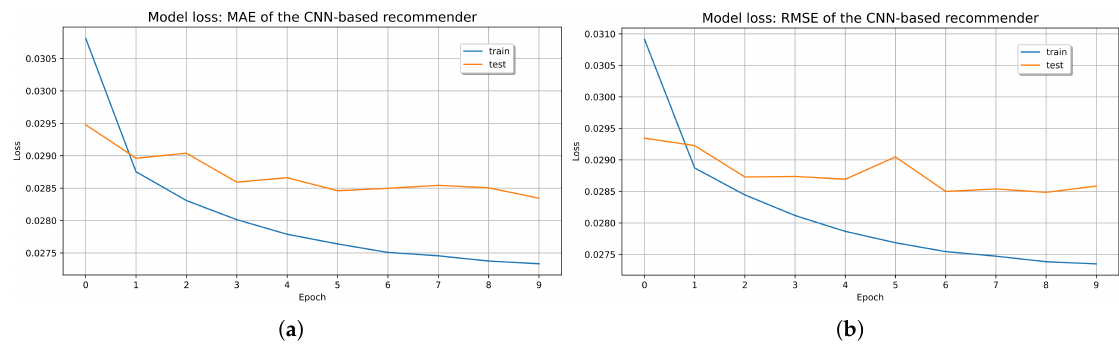
Figure 14. Loss value of CF-CNN ( a ) MAE; ( b )